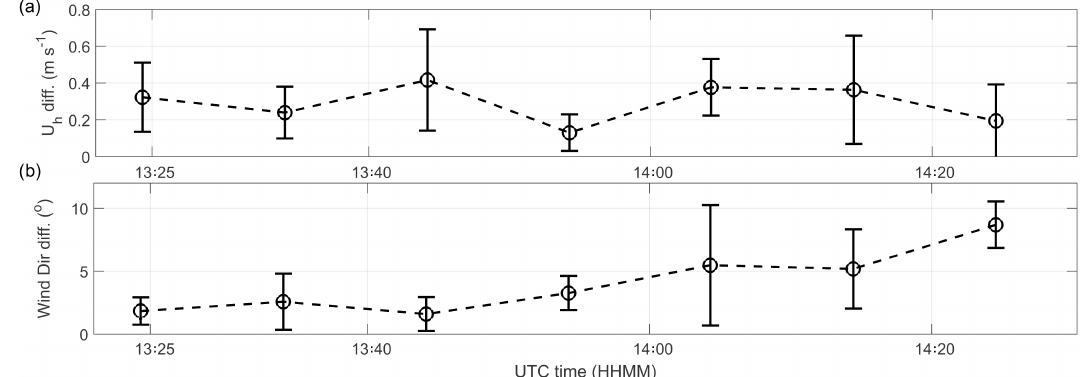
Figure 11. Statistics of the absolute value of the difference between radar and lidar wind data averaged over all the available heights: (a) horizontal wind speed U h (ms − 1 ) difference; (b) wind direction difference. Circles represent mean value, while error bars represent standard